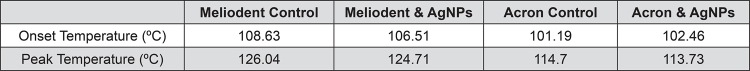
DSC test results